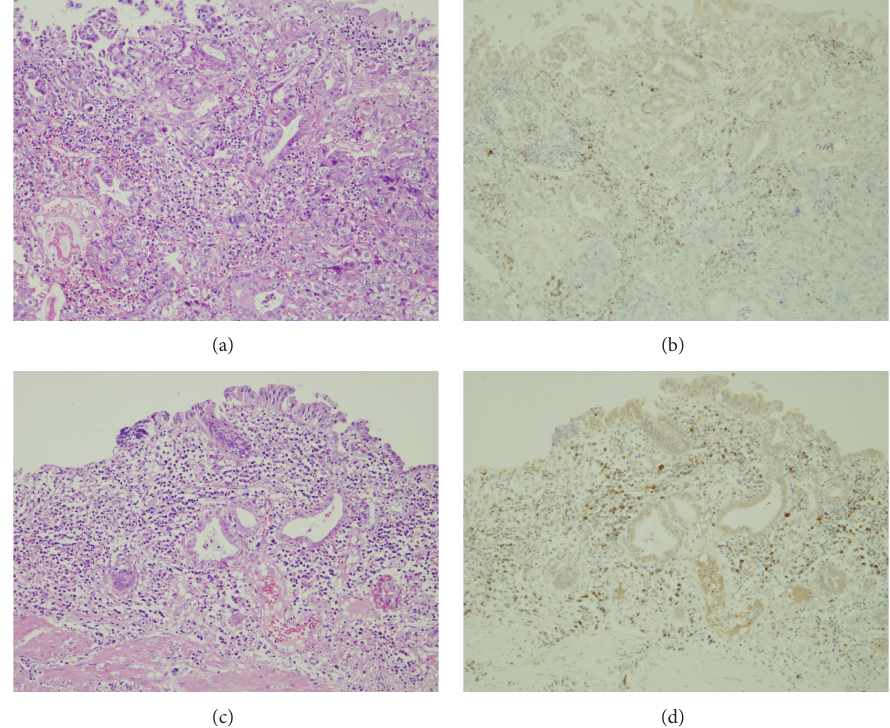
Figure 1: Carcinoma ((a) and (b)) and nonneoplastic ((c) and (d)) areas at the mucosal surface of gall bladder cancer. Severe inflammation ((a) and (c)) and many IgG4-positive cells ((b) and (d)) were found in both neoplastic and nonneoplastic areas. (a) and (c) hematoxylin and eosin stain (HE); (b) and (d) IgG4